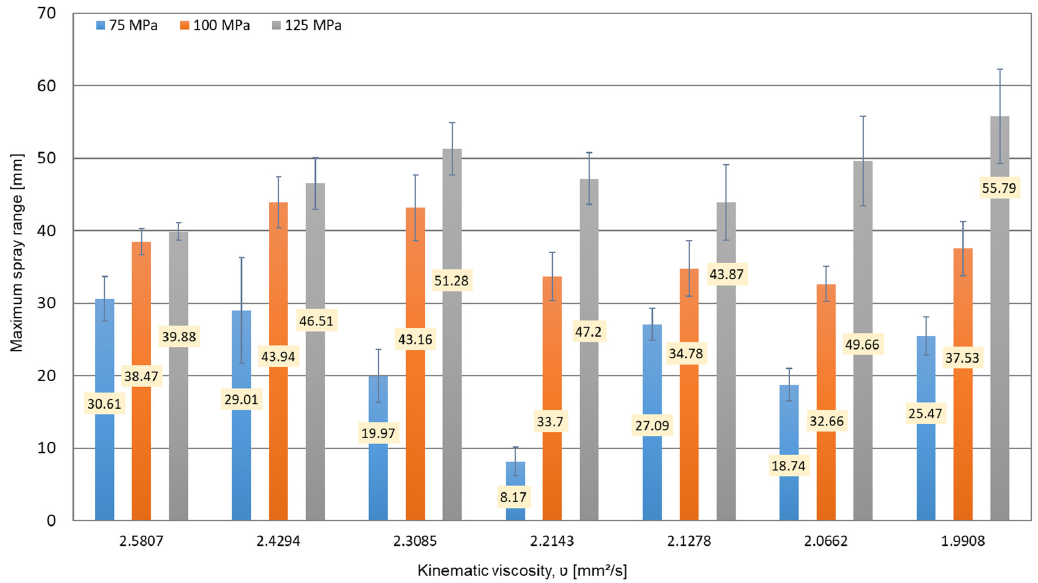
Figure 8. The compared mean values of the maximum spray range of the fuels investigated.